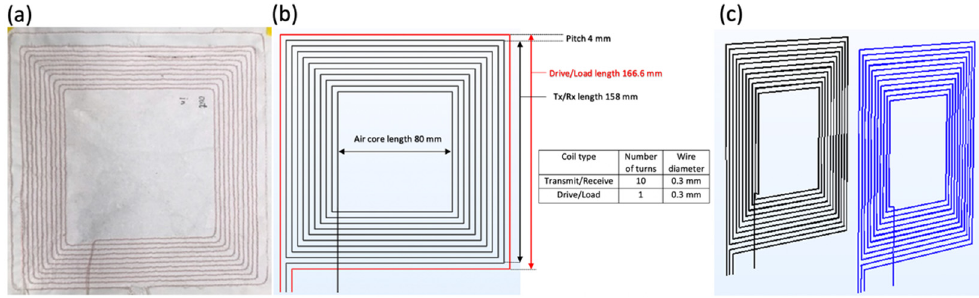
Figure 3. ( a ) Photograph of embroidered textile coils. ( b ) Geometry and layout of coil models for Tx and Rx. ( c ) Tx and Rx of the four-coil system spaced at a certain